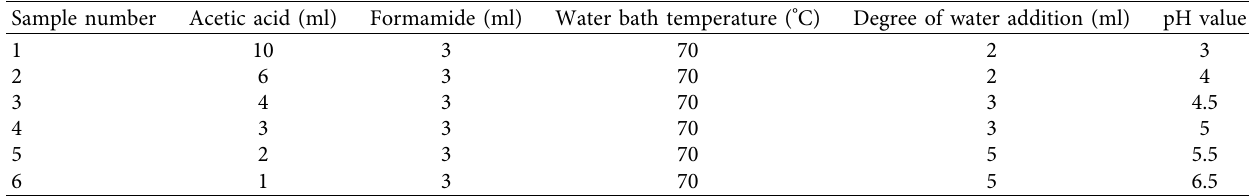
Table 2: Preparation parameters of precursor solutions with different pH values.